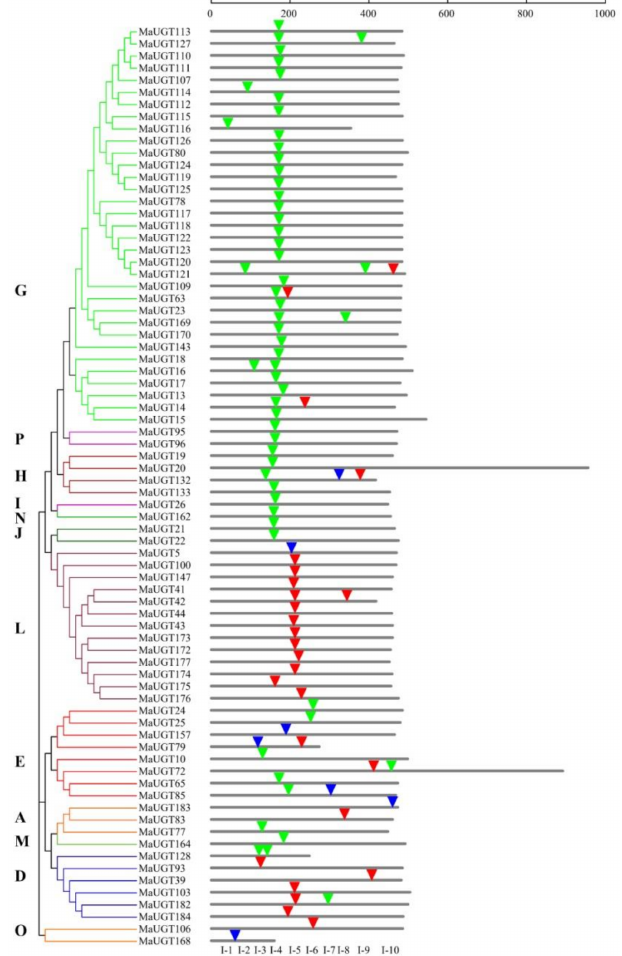
Figure 2. Intron distribution among 76 MaUGT genes. The introns were mapped and numbered to the alignment of the amino acid sequences encoded by the UGT genes. The scale on the top of the map shows the intron insertion on each gene. Grey thick lines indicate the length of the amino acid sequences. Inverted triangles indicate the positions of introns that occurred on each gene. Intron phases are indicated by red triangles, green triangles, and blue triangles for 0, 1, and 2, respectively. The classification of MaUGT genes is indicated by the phylogenetic relationship on the left, and different phylogenetic groups are distinguished by different